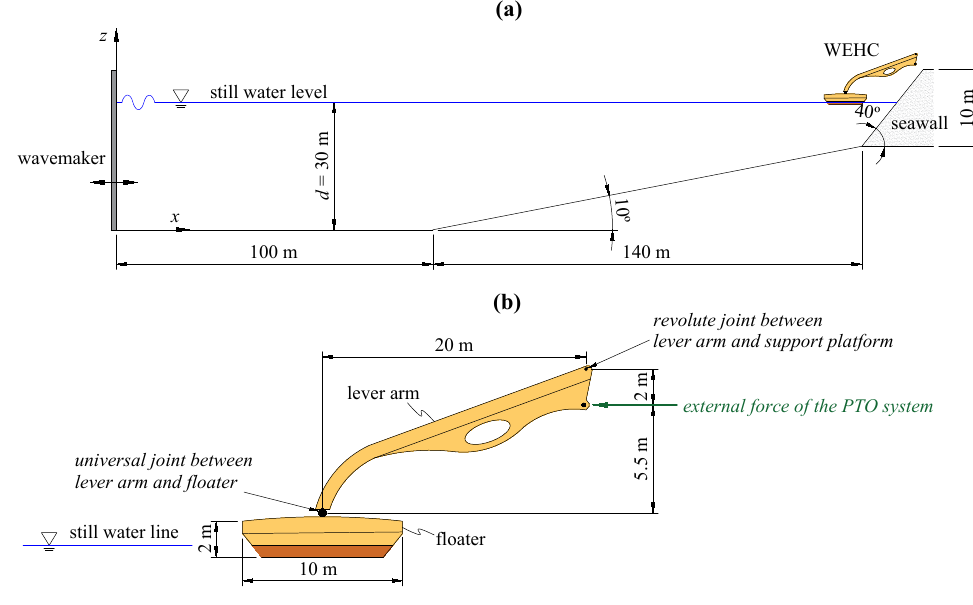
Figure 6. Schematic (side view) of the numerical set-up: ( a ) channel with the full-scale WEHC (not to scale); ( b ) dimensions (in m) of the WEHC